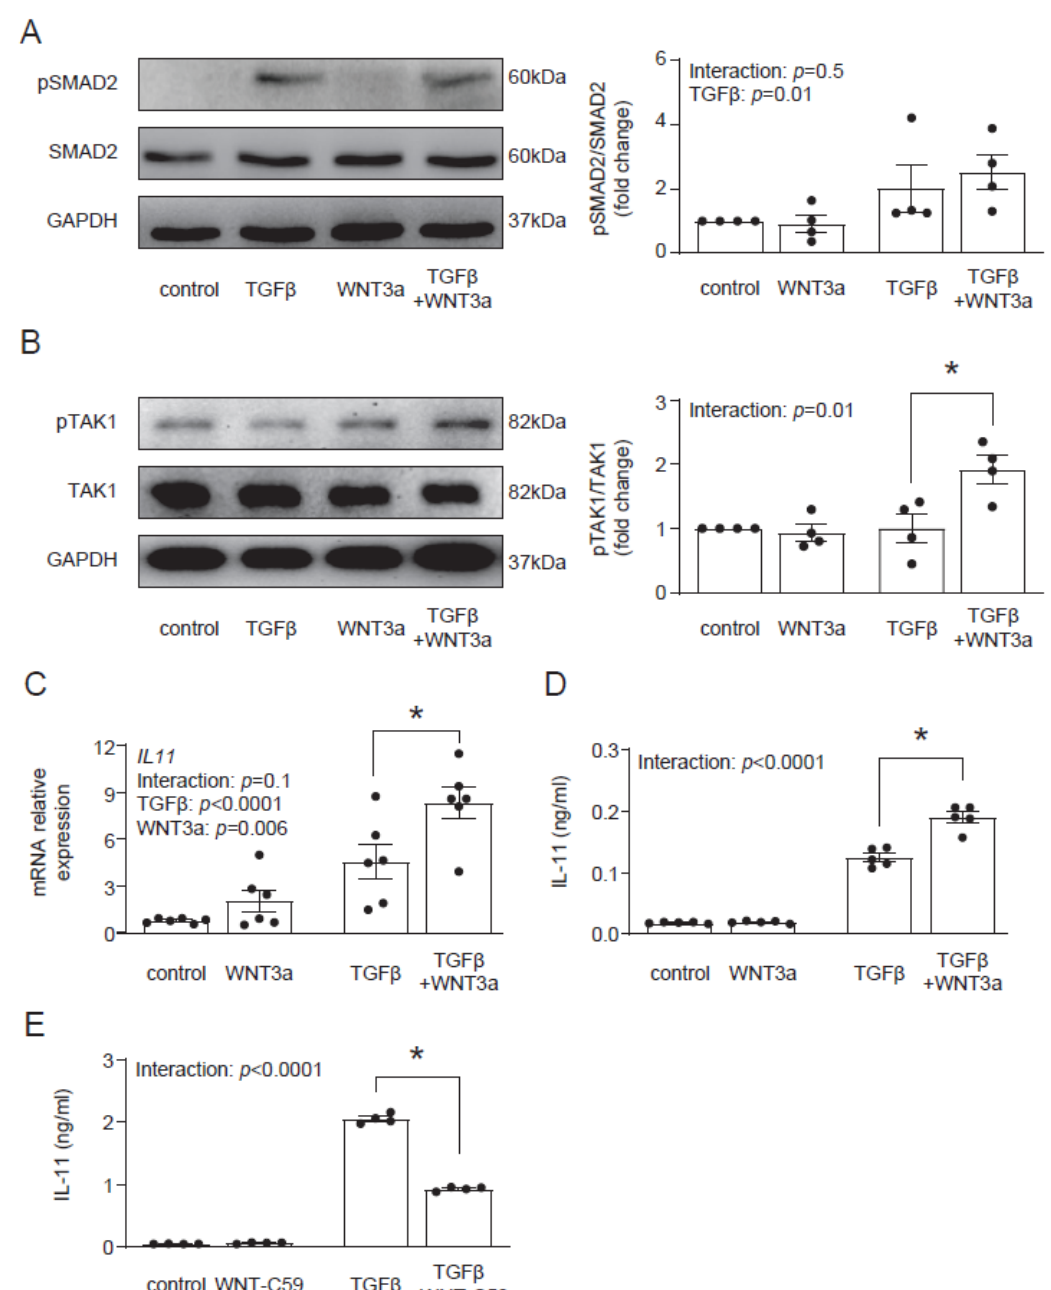
Figure 5. WNT3a enhances TAK1 activation and IL-11 production in TGF- β -activated fibroblasts. Representative im- munoblots and the respective quantification of p-SMAD2/SMAD2 ( A ) ( n = 4) and p-TAK1/TAK1 ( B ) ( n = 4) in cardiac fibroblasts stimulated with Wnt3a and/or TGF- β for 1 h. Panel ( C ) indicates IL11 gene expression (24 h n = 6) and panel ( D ) secreted IL-11 protein level in supernatants (72 h n = 5) of cardiac fibroblast stimulated as indicated. Panel ( E ) shows secreted IL-11 proteins in supernatants ( n = 4) of cardiac fibroblast stimulated with or without TGF- β for 24 h in the presence or absence of the WNT secretion blocker WNT-C59. Bars and whiskers represent means ± SEM. Main effect of WNT3a or WNT-C59, TGF- β and their interaction were tested using two-way ANOVA followed by Tukey’s multiple comparisons test, when the p -value for interaction was ≤ 0.1; * p < 0.05 (post-hoc TGF- β vs. TGF - β+WNT3a or TGF - β vs. TGF - β+WNT -C59).